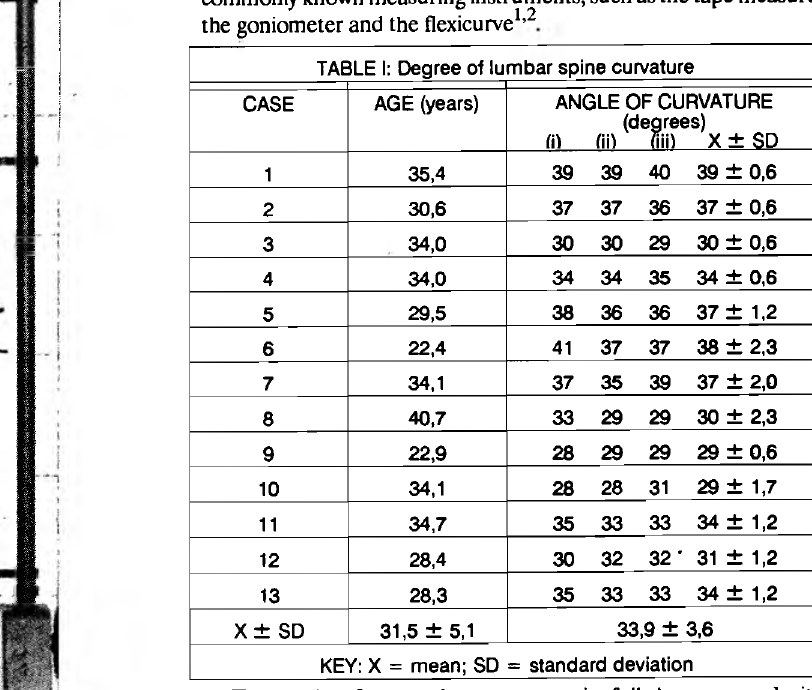
TABLE I: Degree of lumbar spine